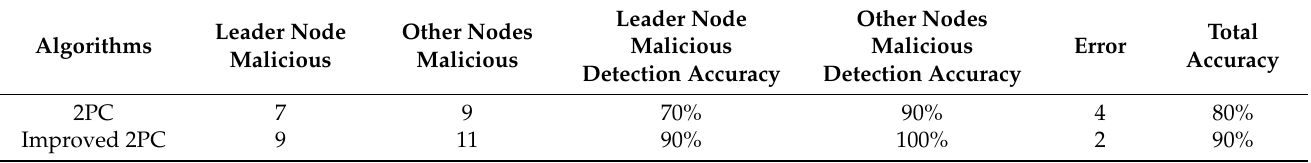
Table 2. Security analysis of the cross-shard transaction processing